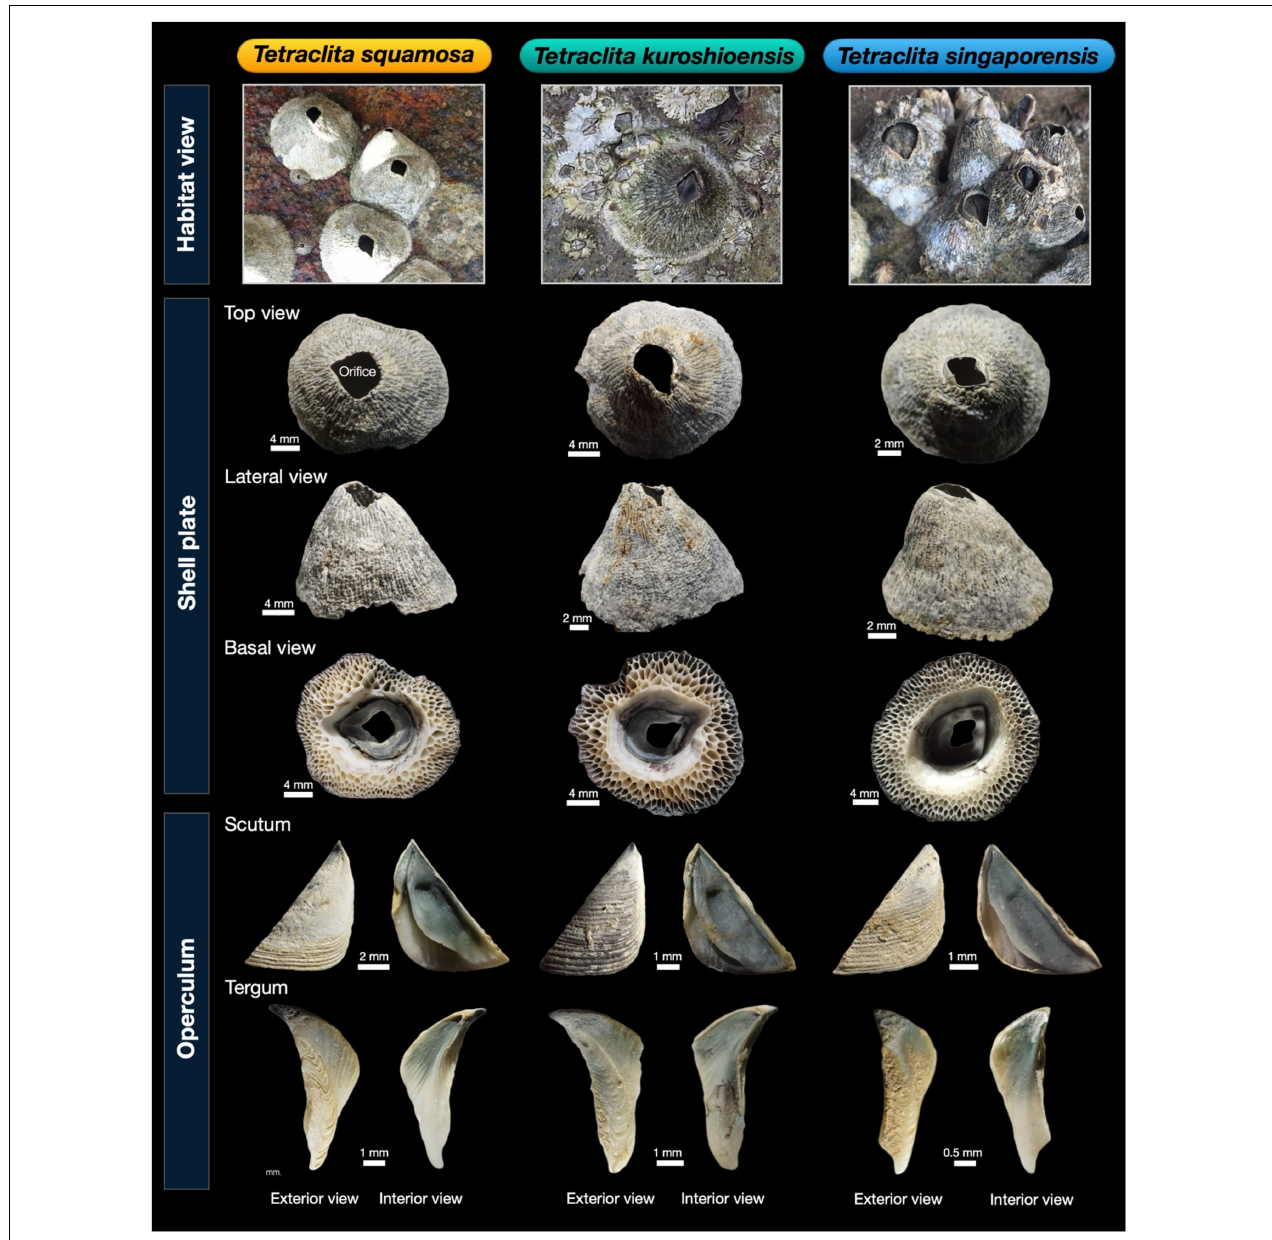
FIGURE 2 | Morphology of shell and opercular plates (tergum and scutum) of Tetraclita spp. specimens from Thailand.